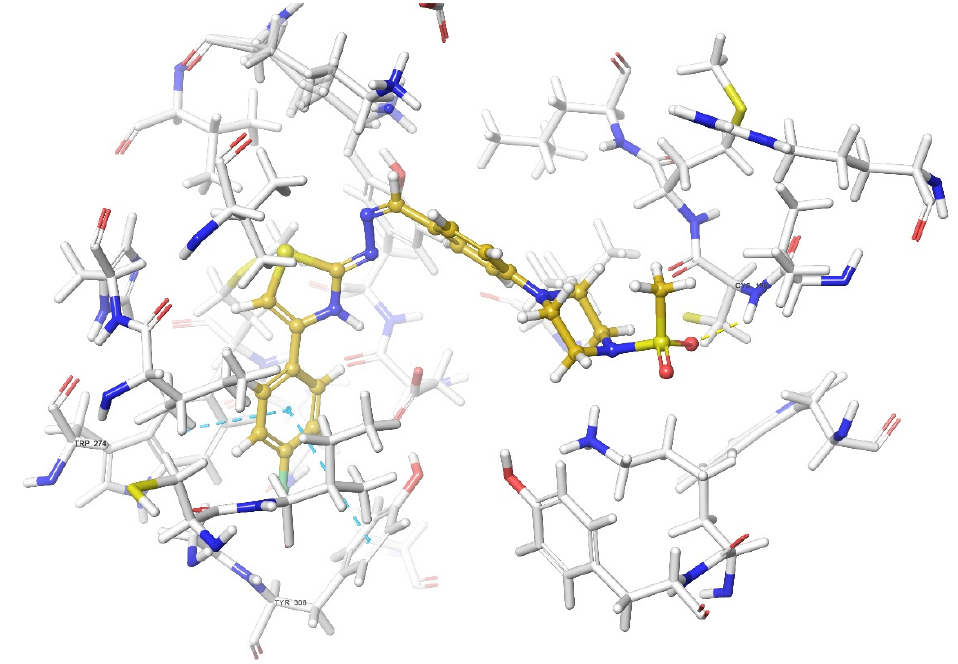
Figure 17. The three-dimensional interacting mode of compound 3f in the active region of δ -opioid receptor. The ligand and significant residues of the active site of the receptor are presented by a tube model colored with yellow and white, respectively (PDB Code: 4N6H).